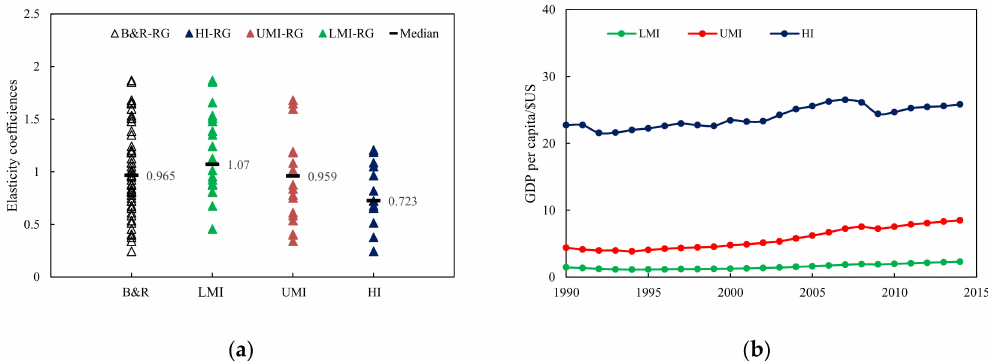
Figure 2. The elasticity coefficiences of GDP per capita and its changes in different income groups: ( a ) The elasticity coefficiences of GDP per capita in three income groups; ( b ) The changes in GDP per capita in three income groups from 1990–2014.